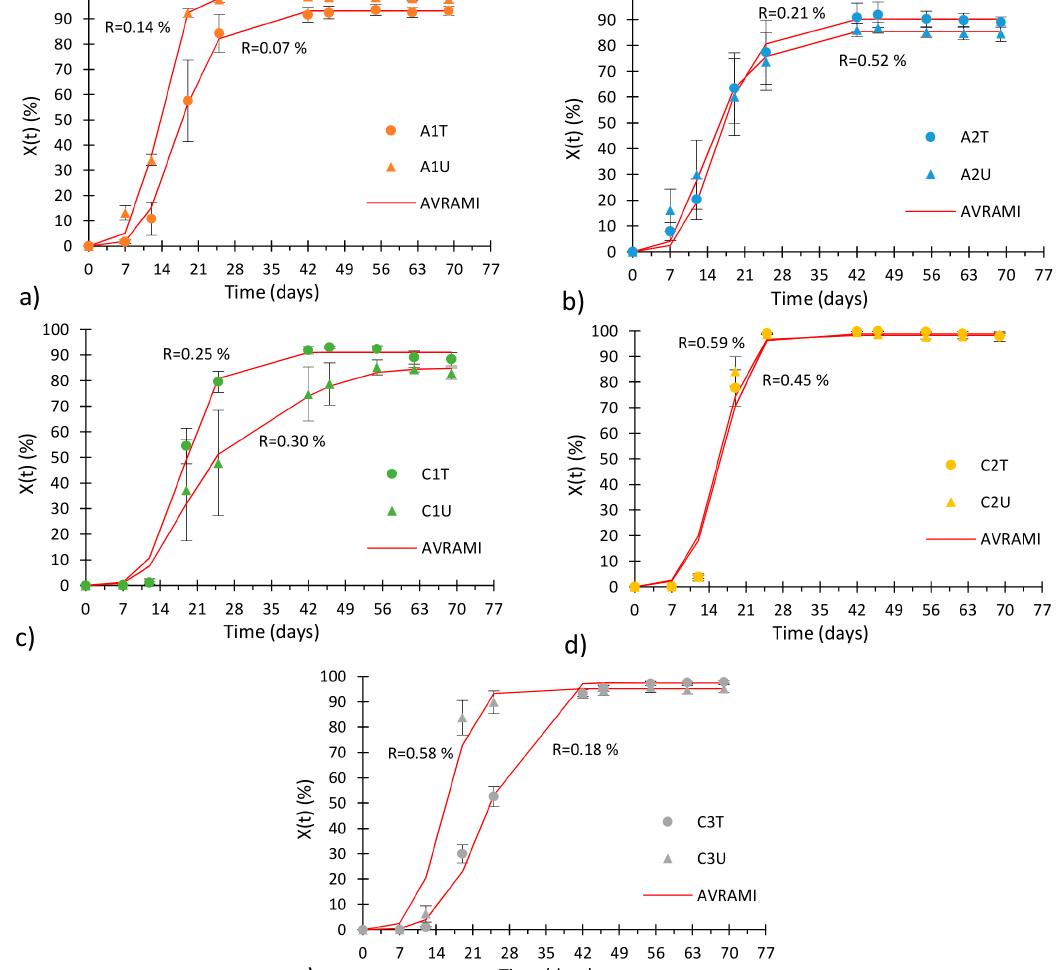
Figure 4. Correlation plots between experimental X ( t ) ( x -axis) and analytical X ( t ) ( y -axis): ( a ) A1T specimen; ( b ) A1U specimen; ( c ) A2T specimen; ( d ) A2U specimen; ( e ) C1T specimen; ( f ) C1U specimen; ( g ) C2T specimen; ( h ) C2U specimen; ( i ) C3T specimen; ( j ) C3U specimen. Dot lines are the bisectors.